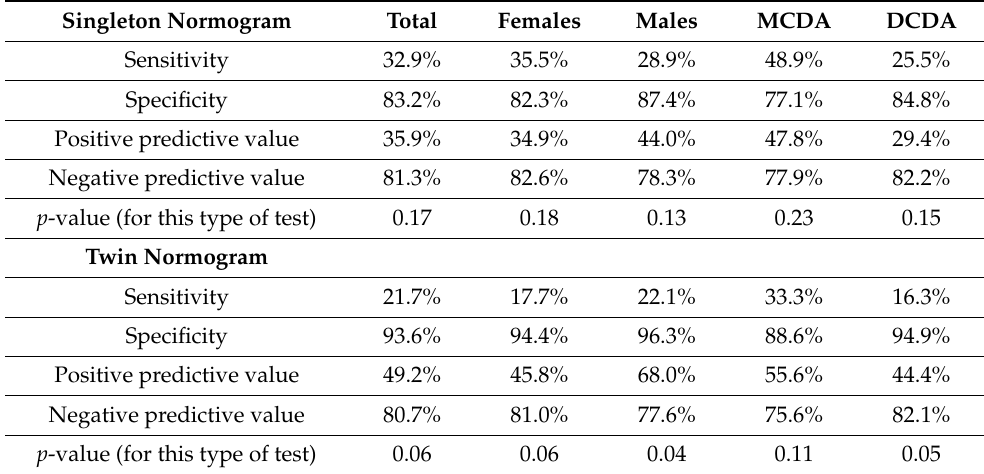
Test performance measures for predicting adverse neonatal outcomes for both growth charts in SGA neonates are presented in Table 3. The ROC curves for singleton and twin charts and AUC are presented in Figure 1. Singleton charts presented higher sensitivity (32.9% vs. 21.7%), yet lower specificity (83.2% vs. 93.6%) compared to twin normogram implementation. Conversely, the twin chart was characterized by higher specificity, which could be a result of selecting growth-restricted twins at the highest risk of developing neonatal complications. The predictive value for a positive result (PV+) appeared to be in favor of the twin chart (49.2% vs. 35.9%), although the predictive value for a negative result (PV − ) remained comparable (81.3% vs. 80.7%) for the singleton and twin normograms, respectively. When the gender was considered, the singleton normogram showed higher sensitivity and PV − for females, with enhanced PV+ in favor of males. The twin charts showed higher sensitivity, specificity, and positive predictive value for males, having more accurate negative predictive value for female gender. Table 3. Sensitivity, specificity, positive and negative predictive values for singleton and twin normograms in detection of SGA